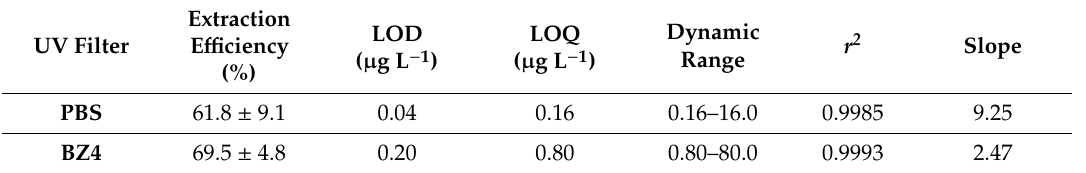
Table 2. Average recoveries, LODs (limits of detection), LOQs (limits of quantification), linear dynamic ranges, determination coe ffi cients ( r 2 ), and slopes obtained for the two UV filters